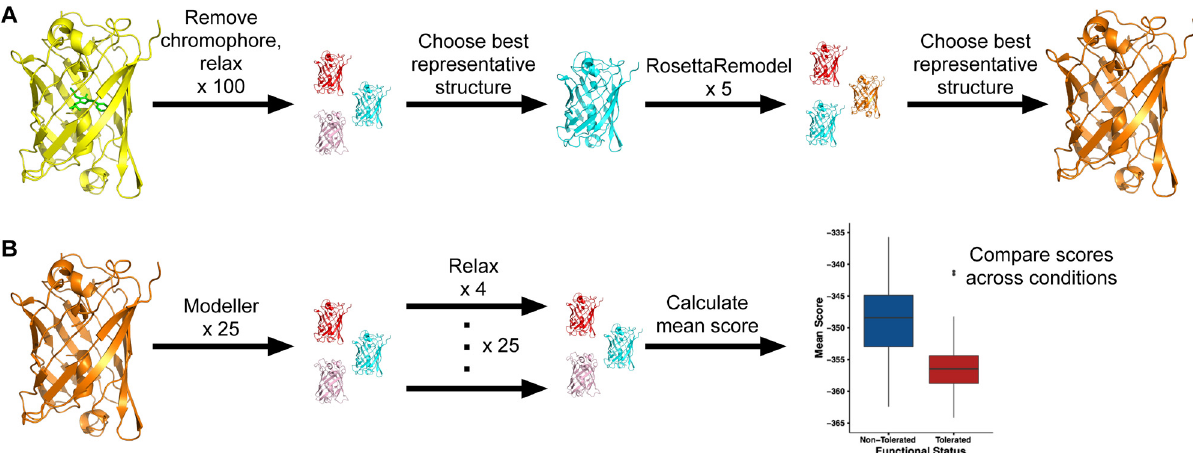
Fig 2. Visualization of the computational modeling pipeline. Colors represent variationbetweenstructural models producedby each protocol. (A) Generating an eGFP structure without chromophore. We first removedthe chromophore and used Rosetta relax to optimize the pared-downstructure. We then chose the lowest scoring model (best representative structure) from the 100 relaxedstructures and reinsertedthe missing residues using RosettaRemodel.Finally, we picked the lowest scoringmodel from this protocolas the template for further analysis. (B) Generating deletion mutants. For each individual deletionmutant we considered, we first generated 25 structures using Modeller.We then refined these structures with Rosetta relax, generatingfour relaxesstructures for each of the 25 Modellerstructures. Finally, we calculatedthe mean score over these 100 models and used this score as a predictor of functionalstatus for each mutant.